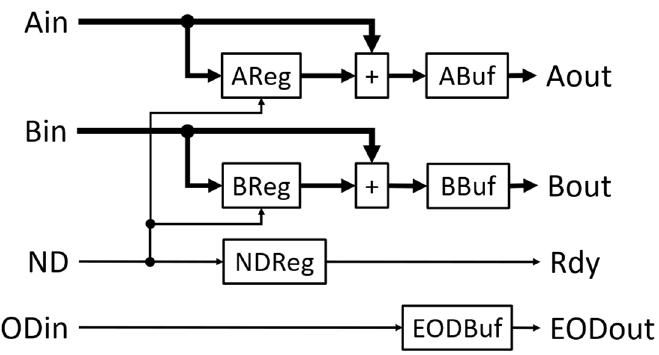
Figure 5. Functional block diagram of the combiner module. Reset signal (not shown in the figure) clears all registers in the module.